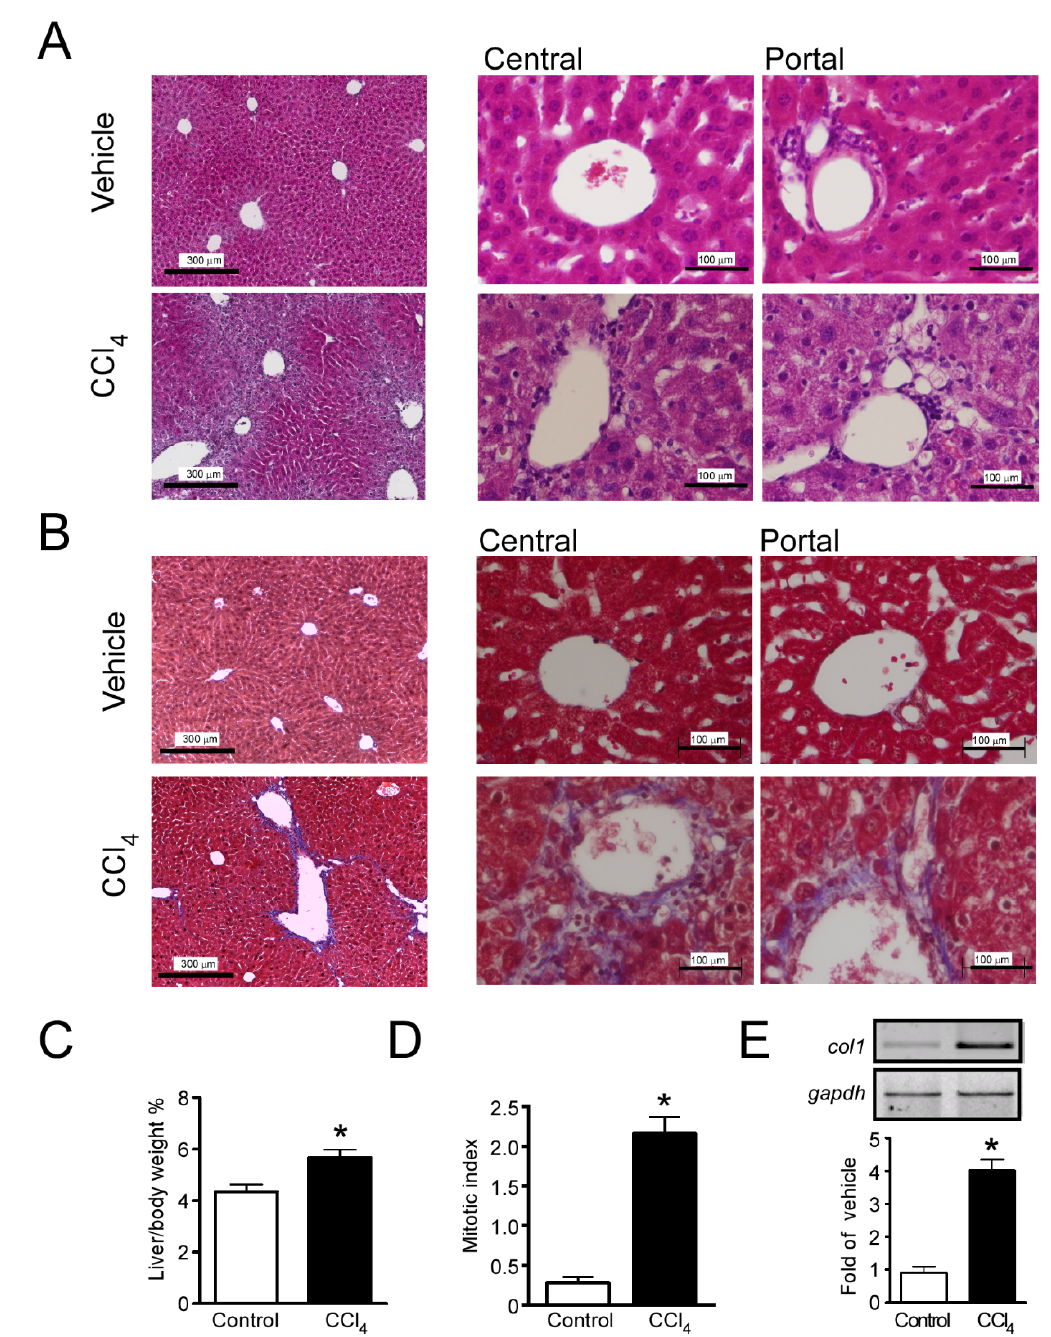
Figure 1. Administration of CCl 4 for 4 weeks induced a fibrotic phenotype. Mice of the C57BL/6 strain were treated with intraperitoneal injections of CCl 4 , three times a week for 4 weeks, then, a histological analysis of liver sections was performed. Hematoxylin and Eosin ( A ) and Masson’s Trichrome stain ( B ) in 5 µm liver slices, showing low magnification fields and central and portal regions, from control and CCl 4 -injected mice ( n = three mice, three slides each). ( C ) Percent of liver/body weight from control- or CCl 4 -injected mice. ( D ) Effects of CCl 4 treatment on the rate of liver mitosis (mitotic index) and E) Expression level of Col1a1 transcript in liver homogenates as a marker of fibrosis. * p < 0.05, Student’s t- test. For C, data are the mean of three mice. In ( D ), results are the average of 72 fields from three livers of each group and in ( E ), five mice per group were analyzed.